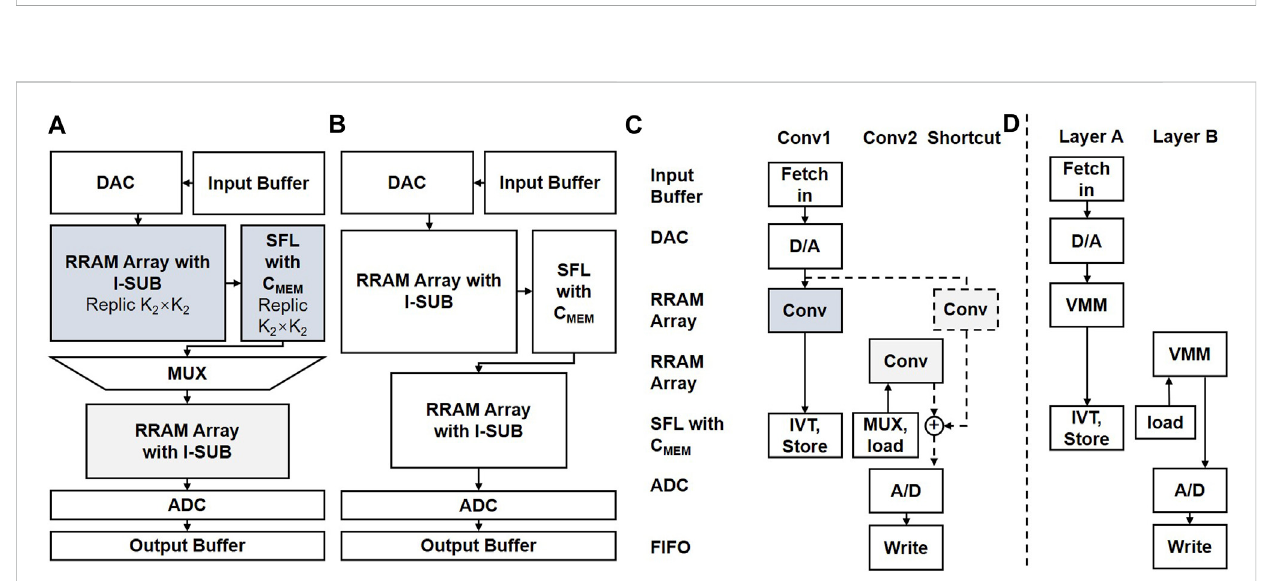
FIGURE 6 Data fl ow between PEs for (A, C) two consecutive convolutional layers and (B, D) other two consecutive layers.